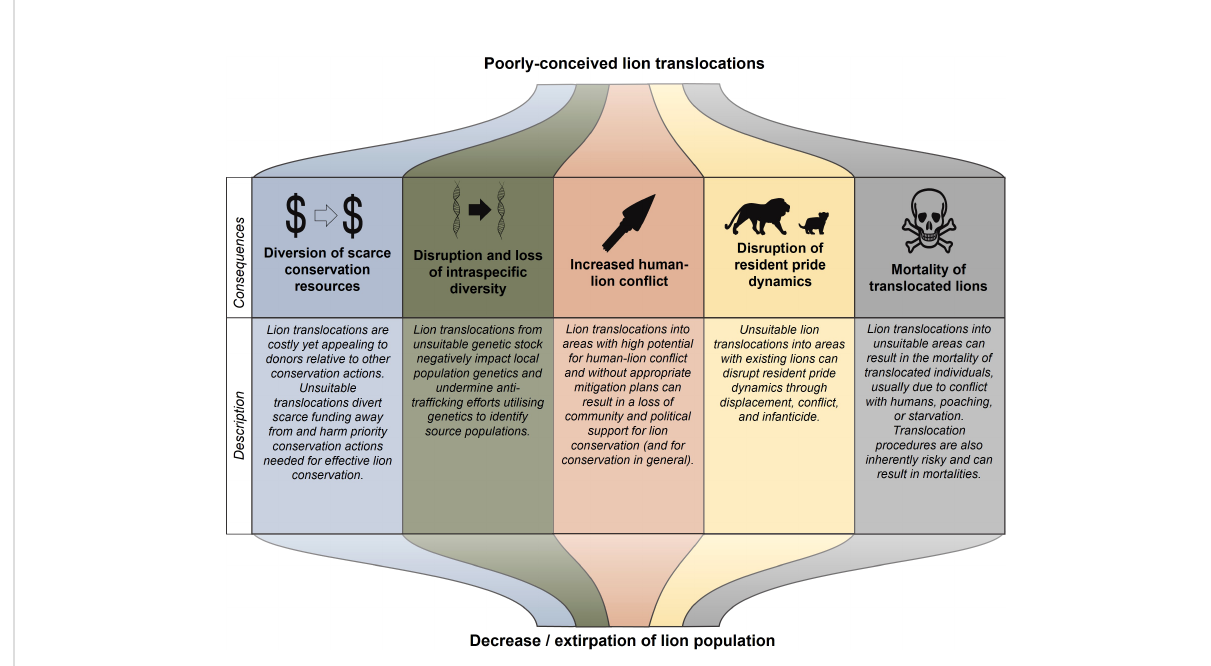
FIGURE 1 Potential negative conservation impacts of poorly-conceived lion